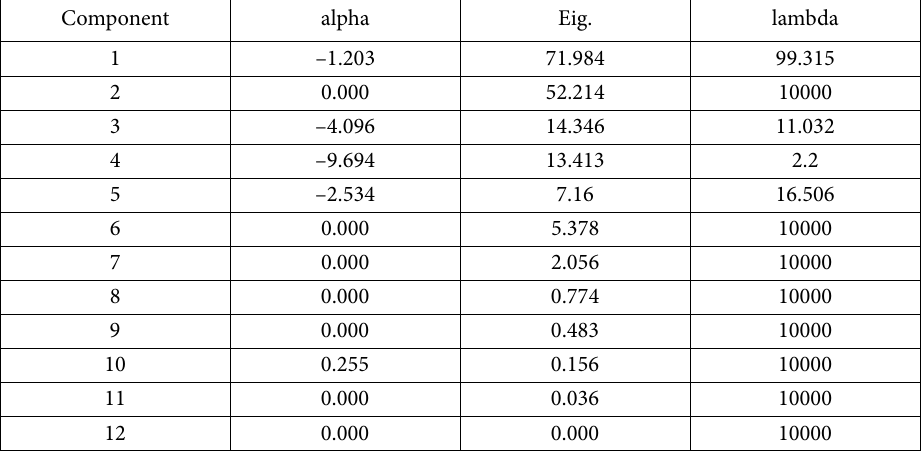
Table 4. Posterior estimates of principal components of explanatory variables in case of Hungary (source: own results) Component alpha